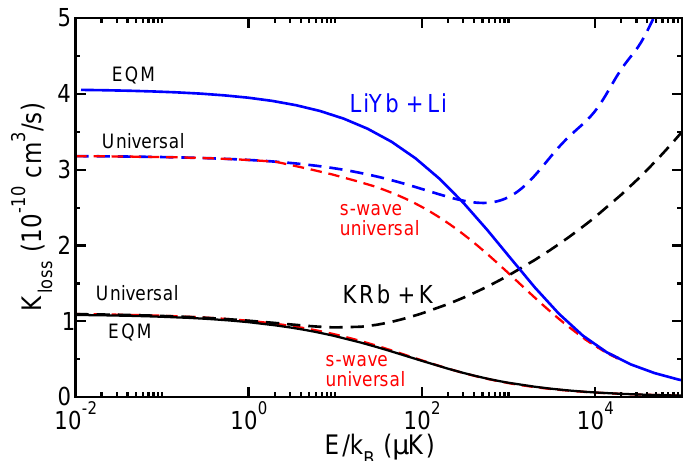
Figure 4. Reaction rate coefficients for LiYb (X 2 Σ + , v = 0, j = 0) + Li and KRb (X 1 Σ + , v = 0, j = 0) + K based on the universal model (dashed lines) and s -wave, (cid:96) = 0 exact quantum coupled-channels simulations based on a full potential energy surface (solid lines) as functions of collision energy. Red and blue dashed curves for LiYb + Li collisions correspond to the s -wave contribution to K loss ( E ) and the total K loss ( E ) based on the universal model, respectively. Red and black dashed curves are corresponding K loss ( E ) for KRb + K collisions The EQM rate coefficients are from References